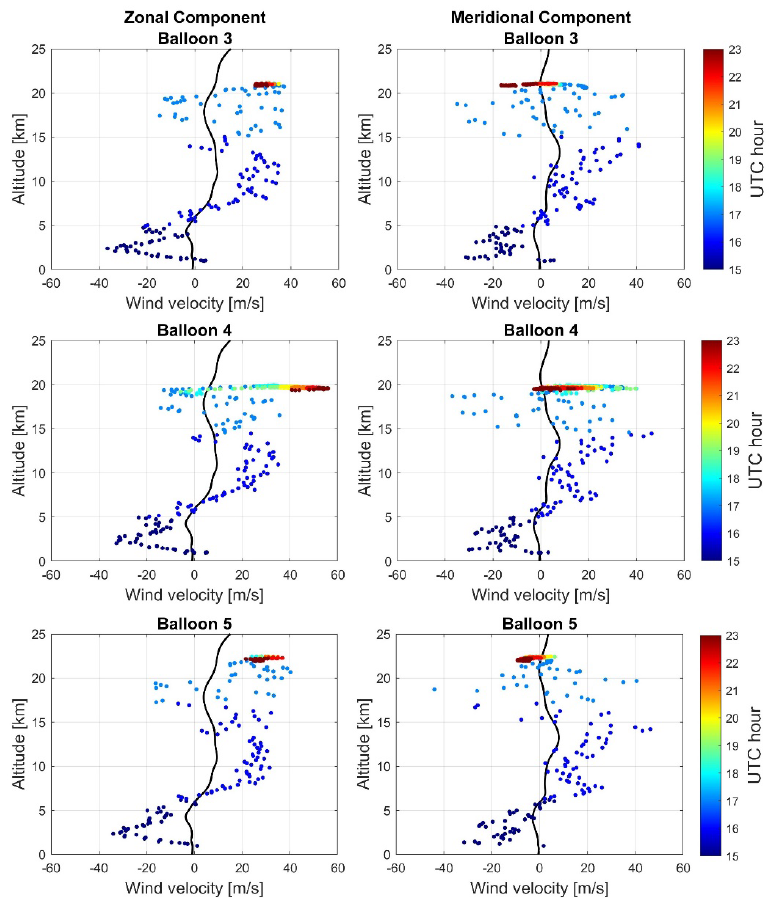
Figure 9. The horizontal motion of the solar hot air balloons in the form of the zonal and meridional velocity components. The horizontal motion points are colored according to the data collection time (in UTC). For comparison, we also plotted the G2S model atmospheric profile at 22:00 UTC. Raytracing results suggest that there exist predicted ray propagation paths for all three balloons along the entire portion of the trajectory that falls within the detection prob-